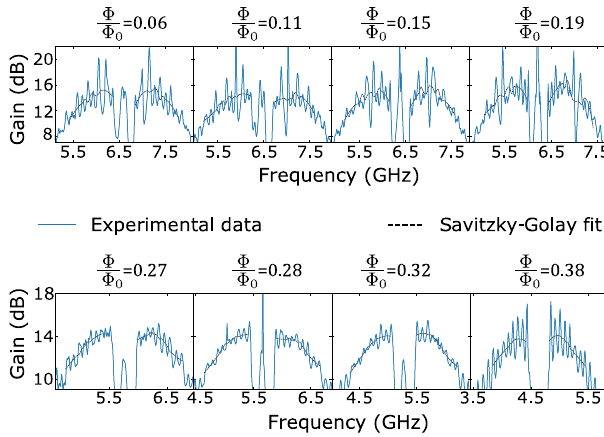
FIG. 18. Smoothing of several gain profiles using a Savitzky- Golay filter. As the maximum gain stays constant for all the fluxes, there is an improvement in the ripples as the characteristic impedance of the STWPA comes closer to 50 Ω . Note that the y -axis scale has a wider range for the upper